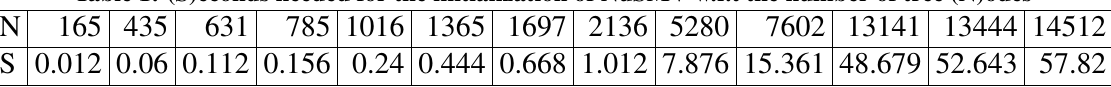
Table 1: (S)econds needed for the initialization of NuSMV w.r.t the number of tree (N)odes